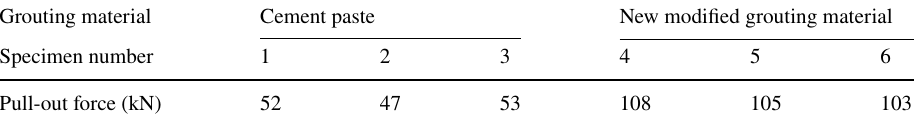
Table 4 Test table of pull- out force of cable bolt under different grouting